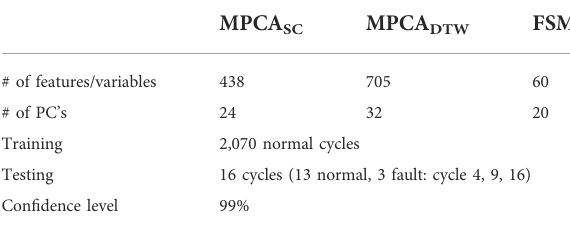
TABLE 2 Training, testing datasets and model